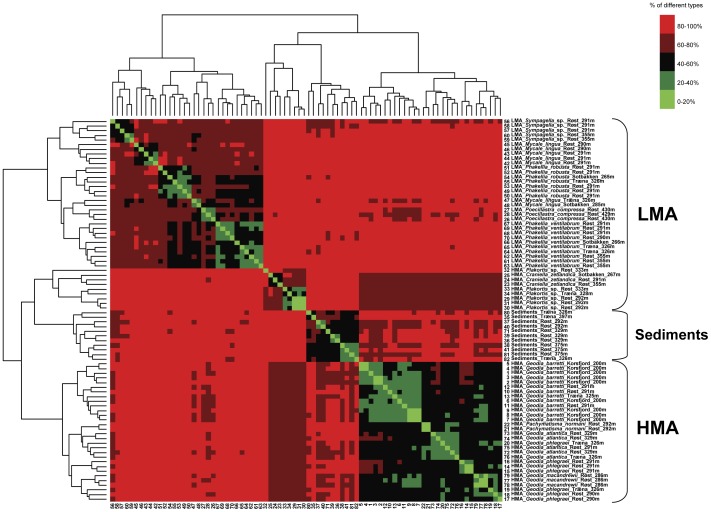
Shared OTUs between all samples.The heatmap depicts the percentage of OTUs shared between any two samples in the study. Community data were also clustered to better reveal the structure in the dataset. Sample names indicate sponge genus, species, reef location, and water depth, as well as specimen identification number.